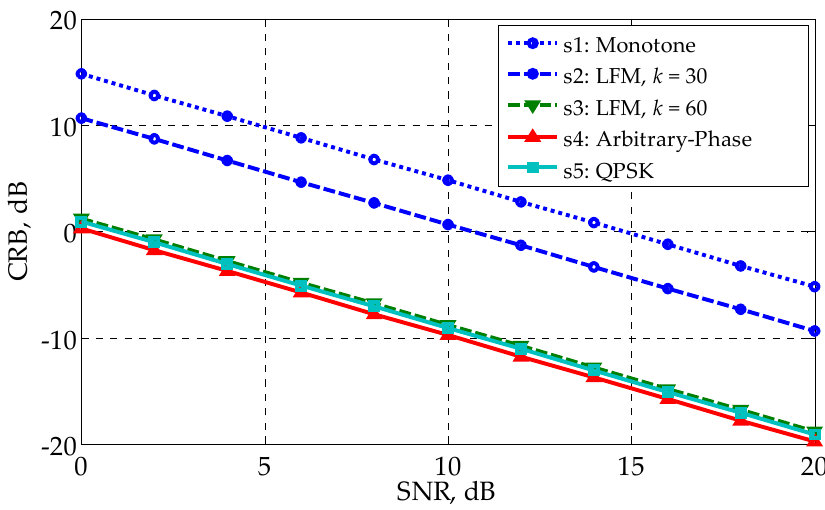
Figure 7. CRB versus SNR for different waveforms in the colored noise.